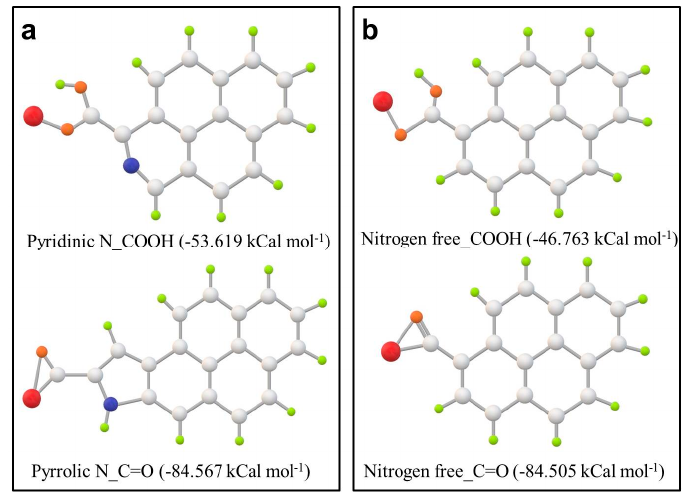
Figure 4. The optimized geometries of phosphorus adsorbed on oxygen-containing functional groups in both ( a ) NC and ( b ) pristine carbon, on the basis of first principles density functional theory (DFT) calculation result. Silver, red, blue, brown, and green balls represent carbon, phosphorus, nitrogen, oxygen, and hydrogen atoms, respectively.